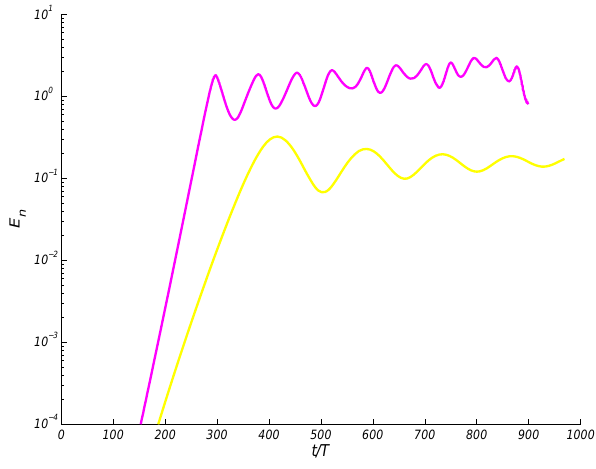
Fig. 6. Theoretical ( — ) and numerical ( – · – ) marginal stability contour lines. ( ◦ ) correspond to numerical results obtained in the framework of Eqs. (4)–(7). The theoretical curve corresponds to the Fig. 1 of Kharif et al.